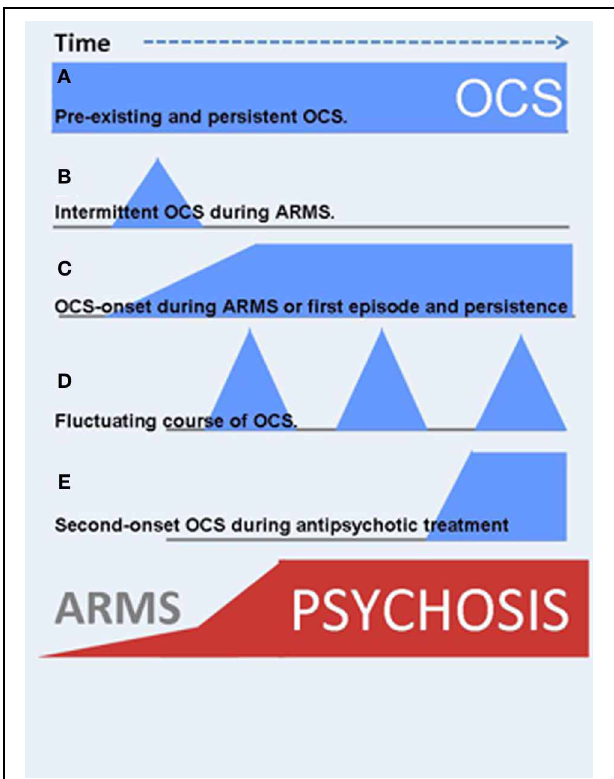
FIGURE 2 | OCS might manifest at different time points during the course of schizophrenia illness. In addition, the clinical course is highly variable. Blue symbols indicate the onset and severity of OCS, red ones are related to psychotic symptoms. (A) Pre-existing and persistent OCS. (B) Intermittent OCS during ARMS or later in the clinical course. (C) OCS-onset during ARMS and persistent course, strongly associated to the psychotic symptoms (schizo-obsessive concept). (D) Fluctuating course of OCS. (E) Second-onset OCS during antipsychotic